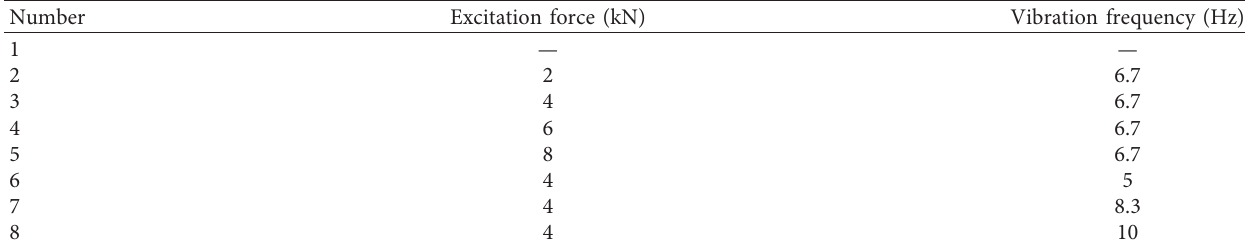
Table 4: Test working